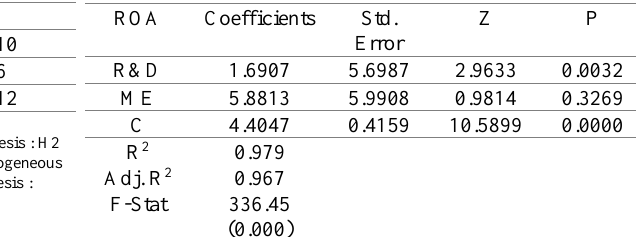
Table 10. Panel homogeneity test results of Model 2